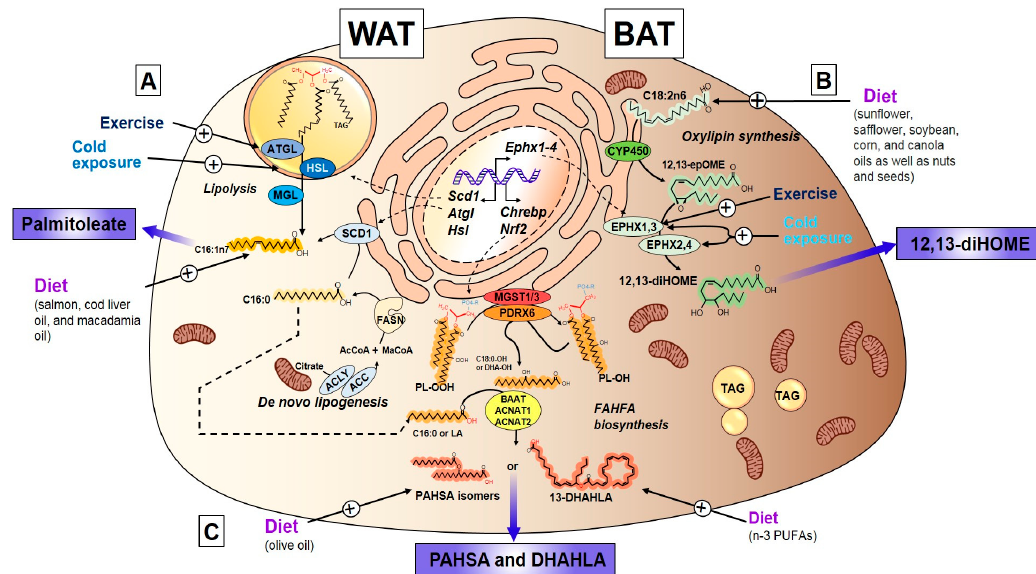
Figure 1. Lipokine synthesis in WAT and BAT. Bioactive lipids termed lipokines are synthesized primarily in adipose tissue from white (WAT) and brown (BAT) adipose depots. ( A ) Palmitoleate can be synthesized in WAT from de novo lipogenesis, starting with the cleavage of mitochondrial citrate by ACLY, followed by the rate limiting enzymes ACC and FASN, generating palmitate or palmitic acid, and further desaturated by Stearoyl-CoA Desaturase (SCD1) into palmitoleate. Palmitoleate can also be obtained from sympathetic-induced, exercise-induced, and cold-induced lipolysis (HSL, ATGL, and MGL) of triglycerides (TAG), which generates the diacylglycerol (DAG) or free fatty acid (FFA) form of palmitoleate. Lastly, palmitoleate can be obtained directly from the diet and provide a bioactive form of cis-palmitoleate or trans-palmitoleate. ( B ) 12, 13-diHOME (12,13-dihydroxy-9Z-octadecenoate) lipokine is primarily synthesized from BAT from essential fatty acid linoleic acid provided in the diet. The first synthetic step involves CYP 450 group of enzymes that give rise to the epoxide 12, 13-epOME, and is hydrolyzed by ER-residing or cytosolic EPHX1/3 or EPHX2/4, respectively. The final hydrolysis step generates 12, 13-diHOME. Both exercise and cold exposure are strong activators of the last step ( Ephx1-4 ) of 12, 13-diHOME synthesis. ( C ) Fatty acid hydroxy fatty acid (FAHFAs) constitute a novel lipid class that act as lipokines including 5-PAHSA, 9-PAHSA, and 13-DHAHLA. FAHFA synthesis is thought to start with the modulation of oxidative stress by Nrf2 and de novo lipogenic factor Carbohydrate Response Element Binding Protein (ChREBP), which regulate the peroxide formation and synthesis of fatty acids. The first step involves the generation of a phospholipid peroxide substrate obtained from membrane residing phospholipids spontaneously oxidized or generated by flavin-containing monooxygenases. The first committed step involves the conversion of the peroxide into a phospholipid with the hydroxy fatty acid by GSH-requiring peroxidases MGST1/3 and PDRX6. This hydroxy-fatty acyl is released from phospholipid and then coupled to an Acyl-CoA generated in de novo lipogenesis, (i.e., palmityl-CoA). This is completed by the action of acyl transferases ACNAT1, ACNAT2, and BAAT. This last step creates FAHFAs with either isomers of PAHSA or DHAHLA. ACLY: ATP-citrate lyase. FASN: Fatty Acid Synthase. ACC: